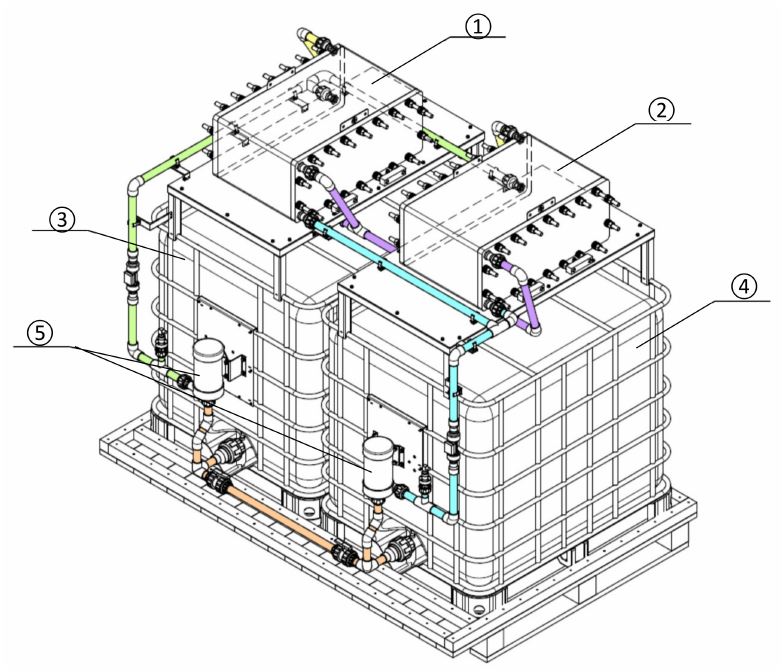
Figure 4. Scheme of a test bench with two flow stacks: 1, 2—VRB stack; 3—positive electrolyte tank; 4—negative electrolyte tank; 5—pumps.